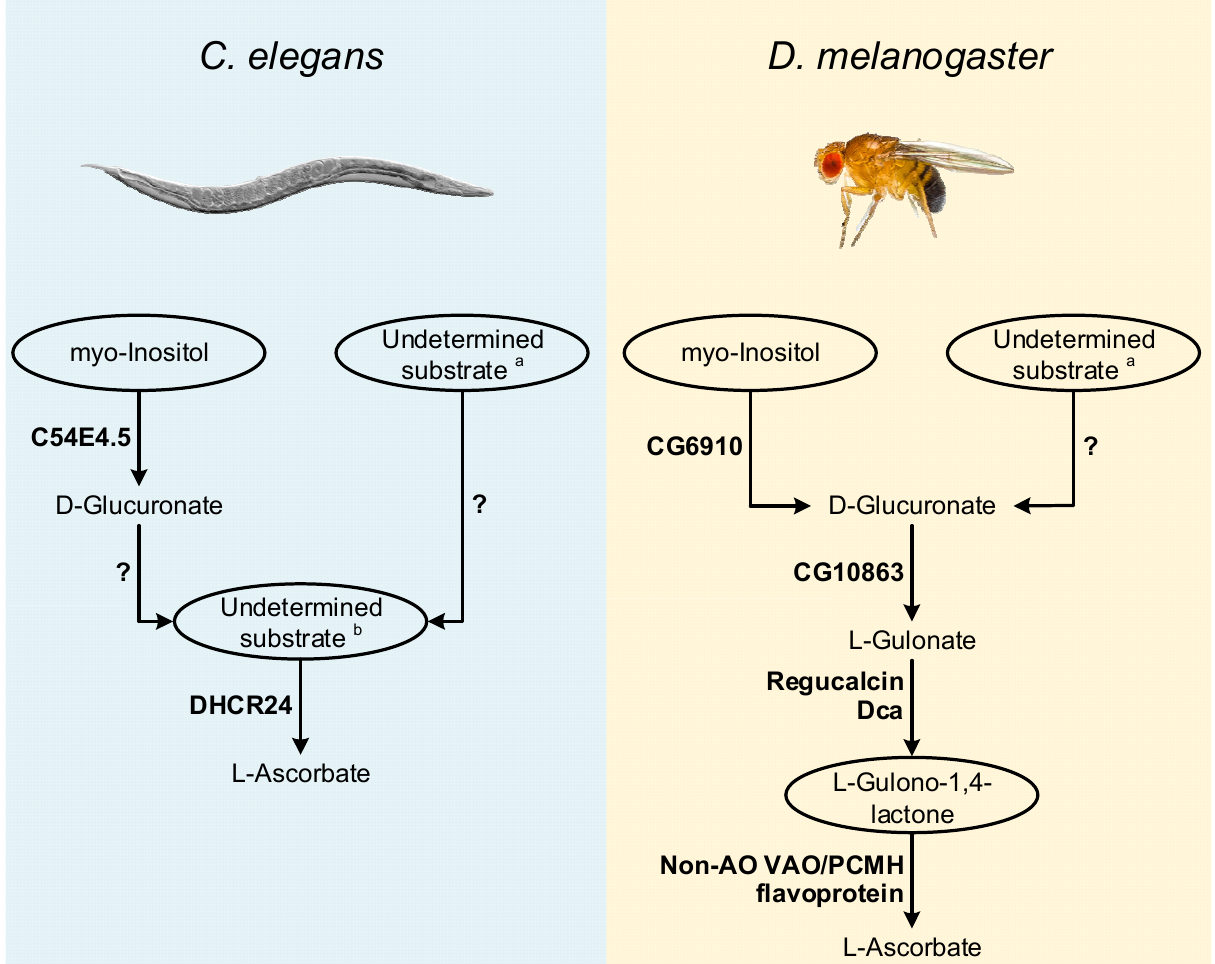
Figure 2. Inferences on enzymatic mechanisms and possible substrates utilized by C. elegans and D. melanogaster in the VC animal synthesis pathways. The ellipses highlight the main substrates possibly used in the proposed pathways, but that remain to be addressed using appropriate experimental setups. Enzymes that may be correlated with VC synthesis in these species are highlighted in bold next to the metabolic steps they are likely to catalyze. The interrogation marks indicate uncertainty in the steps regarding mechanisms of conversion of uncharacterized substrates, and the relative contribution of these processes to the availability of VC precursors. Common sugars (such as D-mannose, L-Galactose, D-Glucose and D-Arabinose) are assigned with a while L-Galactono-1,4- lactone, L-Gulono-1,4-lactone and D-Arabinono-1,4-lactone are assigned with b . Both Dca and Regucalcin likely catalyze the conversion of L-Gulonate to L-Gulono- 1,4-lactone in D. melanogaster , and as such, if Dca is involved in VC synthesis, through a pathway resembling the one found in vertebrates, then the availability of its substrate might be a limiting factor for VC synthesis during cold acclimation conditions. L-Gulonate is obtained by the transformation of D-Glucoronate by the action of the aldo-keto reductases AKR1A1 and AKR1B1 in mammals [186,187] (Figure 1). The catalytical contribution of the two enzymes is very distinct, as AKR1A1 and AKR1B1 are responsible for approxi- mately 85% and 15% of the conversion ratio, respectively [187]. The reduced contribution of AKR1B1 can be explained by its reduced specific activity rather than substrate speci- ficity [188], reflected in the reduced efficiency for D-Glucuronate reduction when compared to AKR1A1 [187]. The human AKR1A1 gene has no orthologs in D. melanogaster (Ensembl accession number ENSG00000117448), but the AKR1B1 gene displays a one-to-many